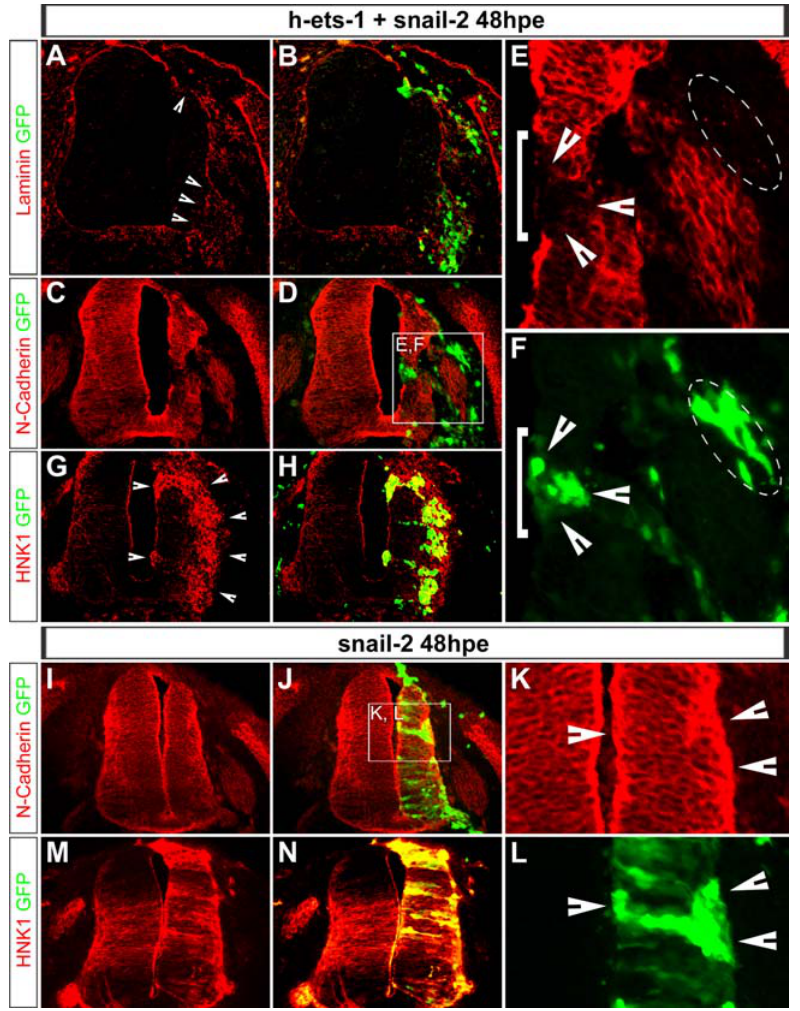
Figure 10. Ets-1and Snail-2Cooperate to Achieve Delamination. (A–N) Analysis of the effects of h-ets-1 and snail-2 coelectroporation (A–H) and snail-2 alone (I–N) in intermediate to ventral neural tube at 48hpe. Transversal cryosections (10 m m) labeled with anti-Laminin (A–B), anti-N-Cadherin (C–F, I–L) and HNK-1 (G–H, M–N) antibodies. Co-electroporated cells degrade the basal lamina (A–B), lose N-Cadherin expression (C–F, white arrow heads and dotted line), cell-cell junctions at the apical side (white bracket) and strongly express HNK1 (G–H). These cells emigrate from the tube as a population of dissociated cells. H-ets-1 and snail-2 , electroporated together, are able to promote EMT and migratory NCCs identity. Conversely, snail-2 electroporation does not affect either N-Cadherin expression or distribution (I–L, white arrow heads). Electroporated cells are unable to undergo EMT and then remain in the neural tube. However, snail-2 electroporation leads to massive ectopic activation of HNK-1 (M–N) all along the dorso-ventral axis of the neural